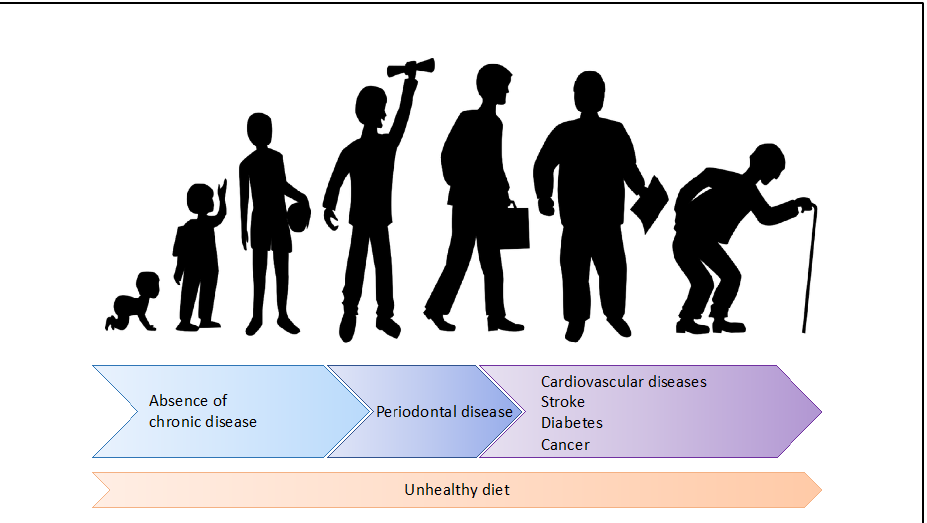
Figure 4. Nutrition as key risk factor of the periodontal disease and other chronic diseases during the life course.